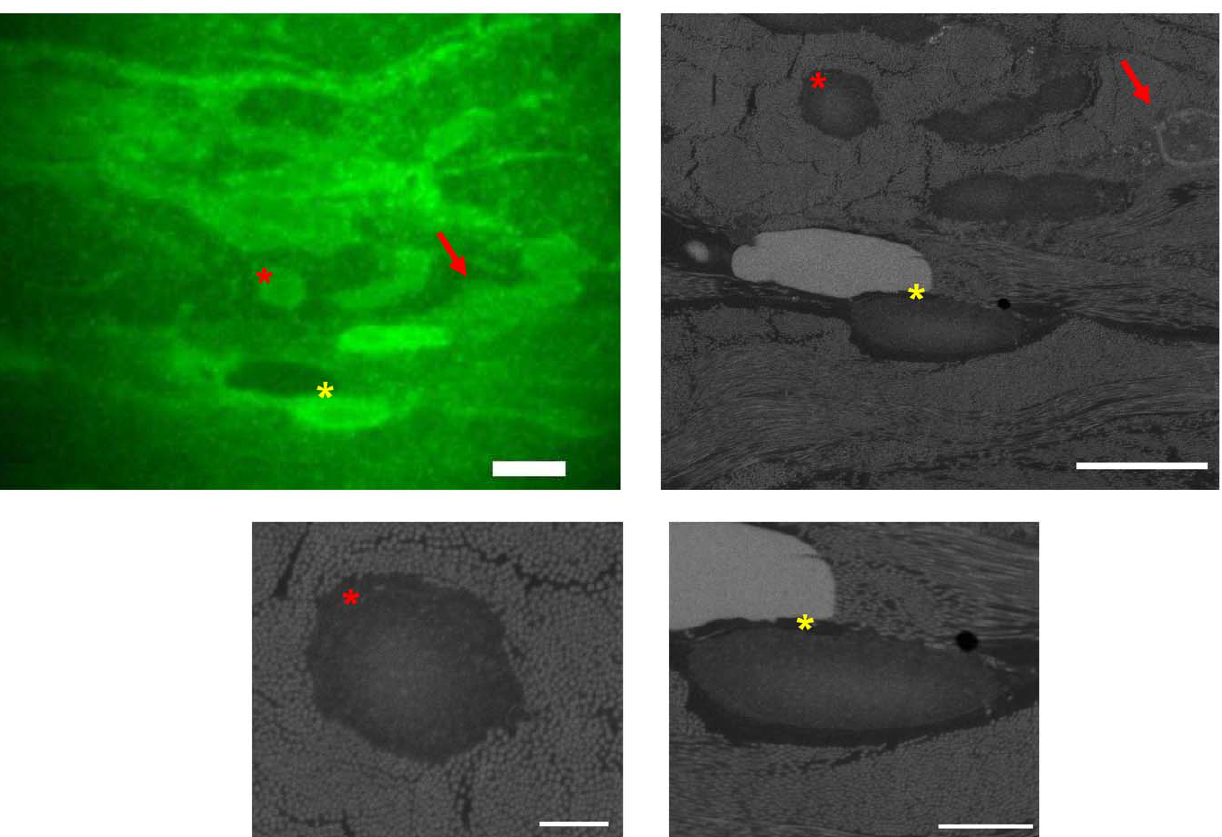
Figure 4. SCLEM on FM and EM stained tissue sections. (a) FM image of human skin tissue stained with DiIC18 fluorescence and uranyl acetate and osmium tetroxide for EM contrast. Scalebar 5 m m (b) BSE image of a selected region from (a), showing a cell nucleus not discernible in (a) (marked with a red arrow), and bundles of longitudinally and transversally cut collagen fibers. Scalebar is 5 m m (c, d) High-magnification images of the areas marked with (c) a red star, scalebar 1 m m, and (d) a yellow star, scalebar 2 m